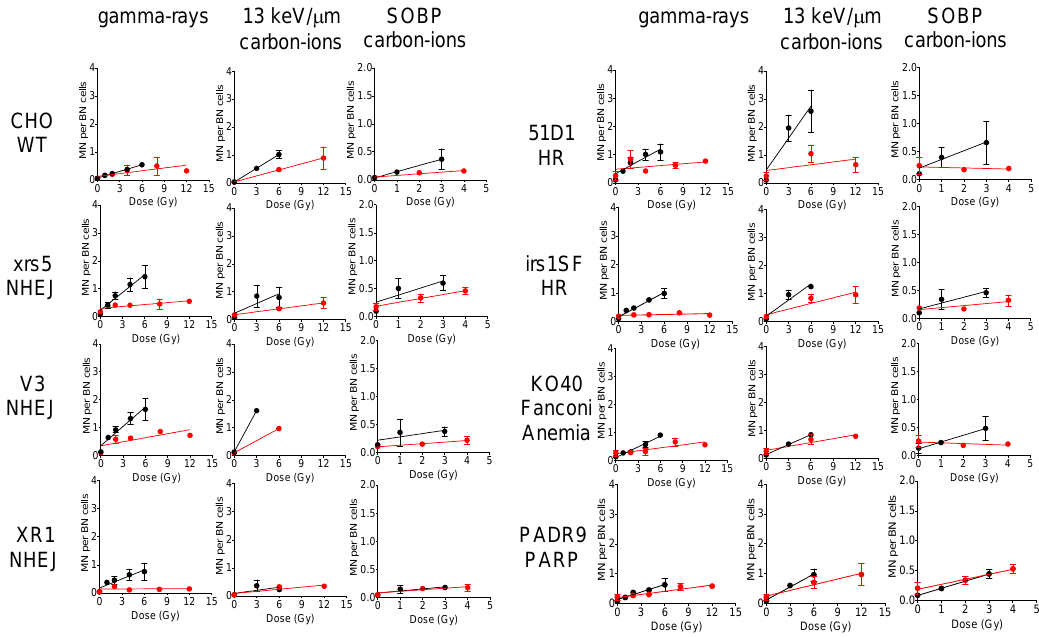
Figure 5. Micronuclei formation assay after different qualities of irradiation in the presence or absence of oxygen. Black circles indicate aerobic condition and the red circles indicate hypoxic condition. All experiments were carried out three times independently.